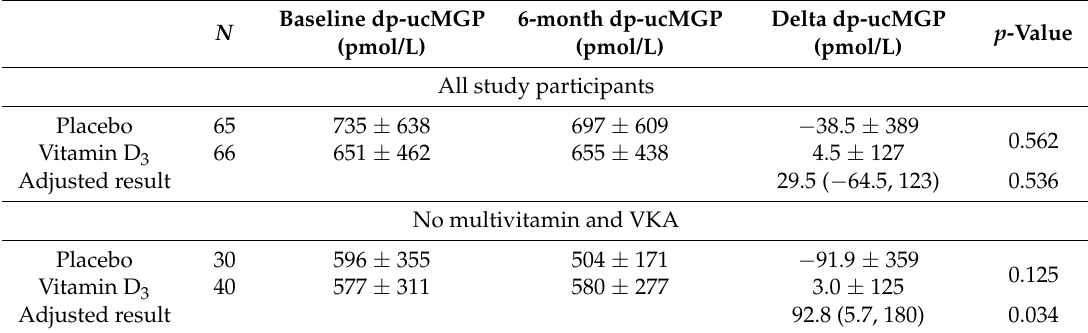
Table 2. dp-ucMGP concentrations at baseline and 6-month follow-up by intervention